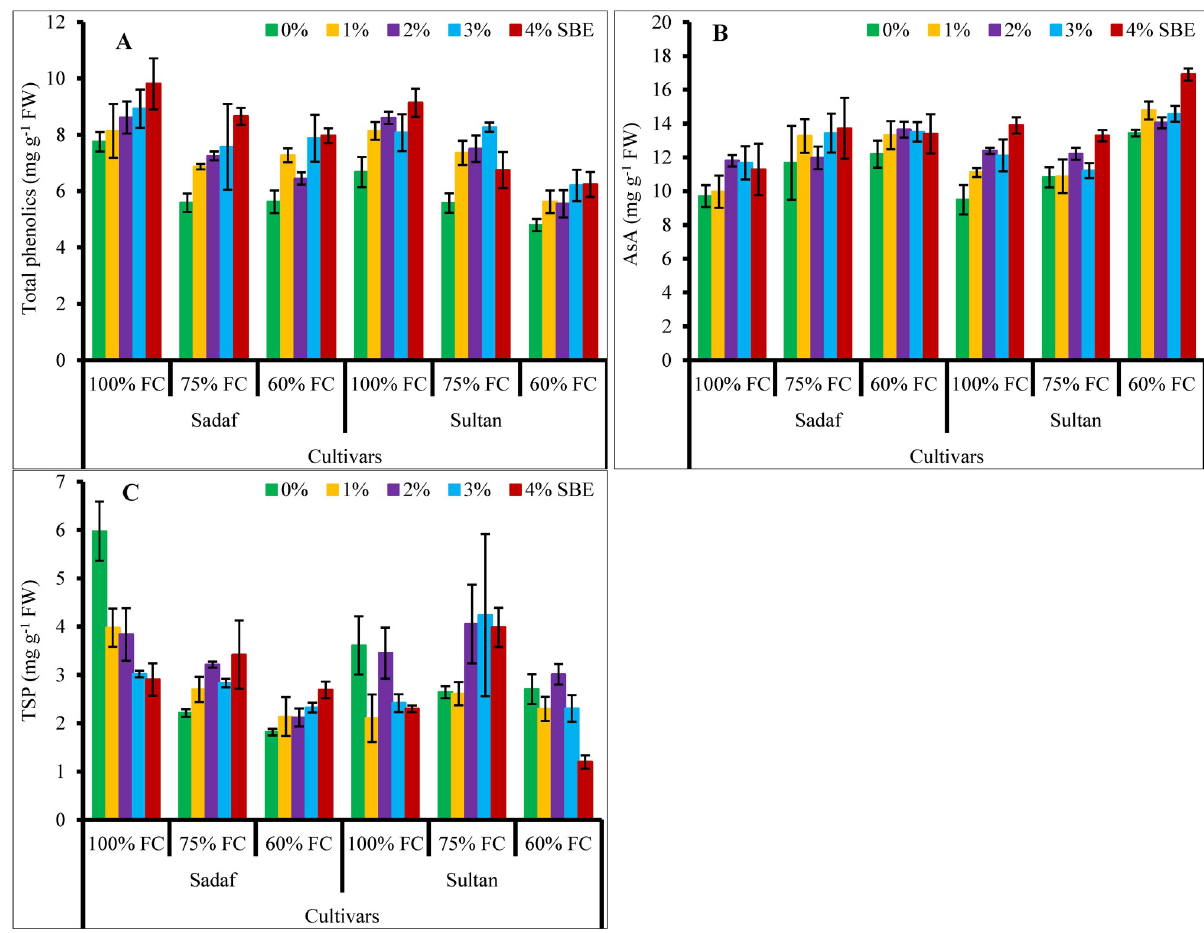
Fig 6. Effect of sugar beet extract (SBE) on (A) total phenolics, (B) ascorbic acid (AsA) and (C) total soluble proteins (TSP) of maize plants subjected to water-deficit stress ( n = 3; Mean ± S.E.).